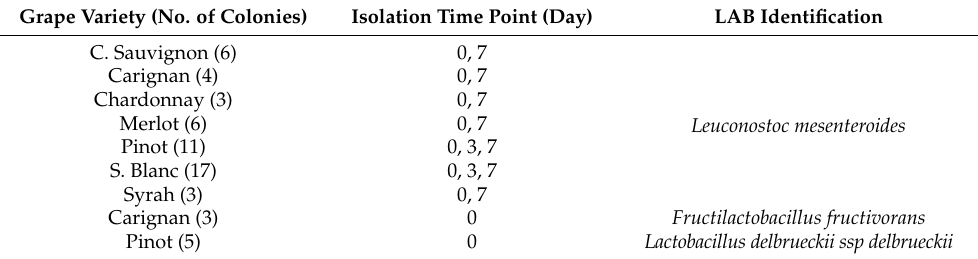
Table 3. Identification of the LAB colonies isolated from the spontaneous grape juice fermentations. Colonies piqued represented a unique colony morphology. The colonies isolated were identified based on the 16S rRNA